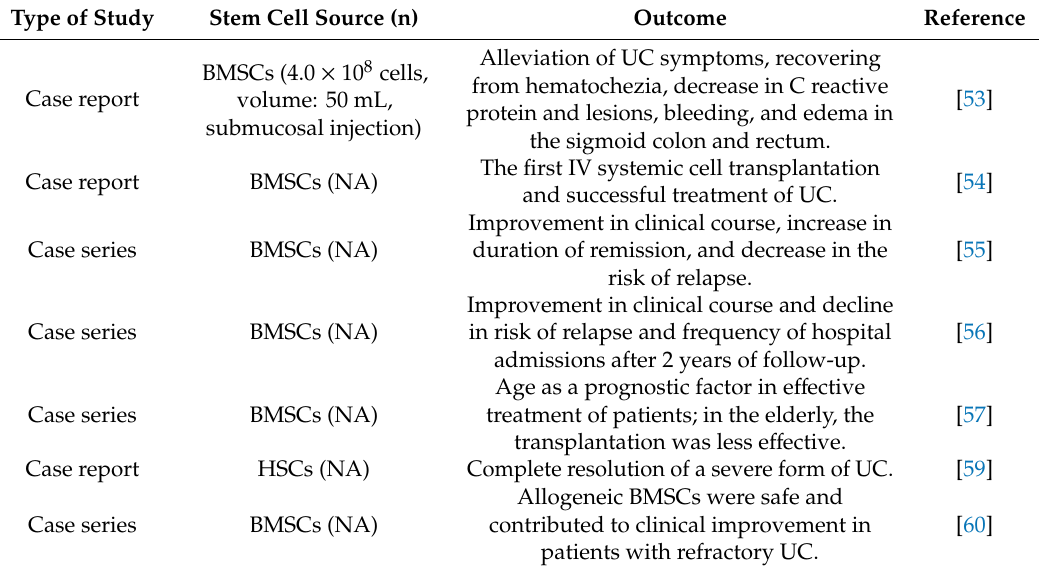
Table 1. Undertaken case reports in the treatment of ulcerative colitis (UC) by various sources of MSCs.